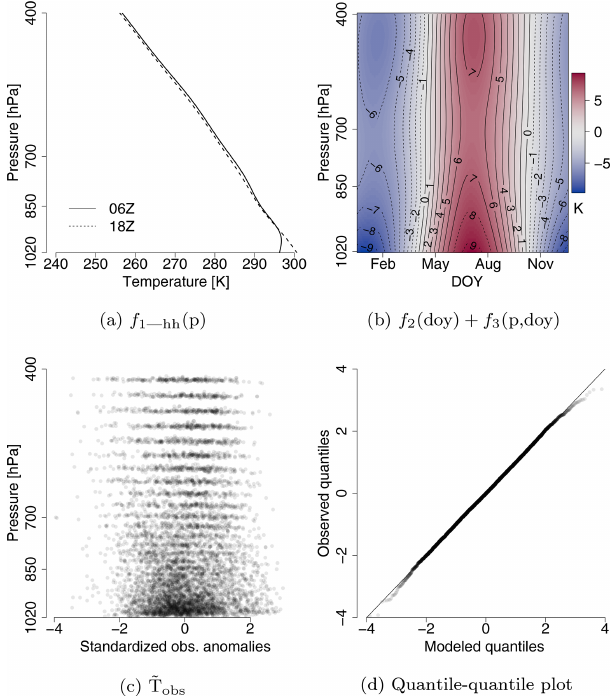
Figure 2. Effects of the climatology of observations y for station Bergen (a, b) for the terms f 1|hh (p) (hh = 06:00 and 18:00UTC, respectively, with fixed doy = 180) and the combined effects of f 2 (doy) + f 3 ( p, doy) (for hh = 06:00UTC); (c) is the standard- ized anomalies of T obs used in the SAMOS approach and (d) the quantile–quantile plot of (c) against an idealized Gaussian distribu- tion with an idealized straight solid